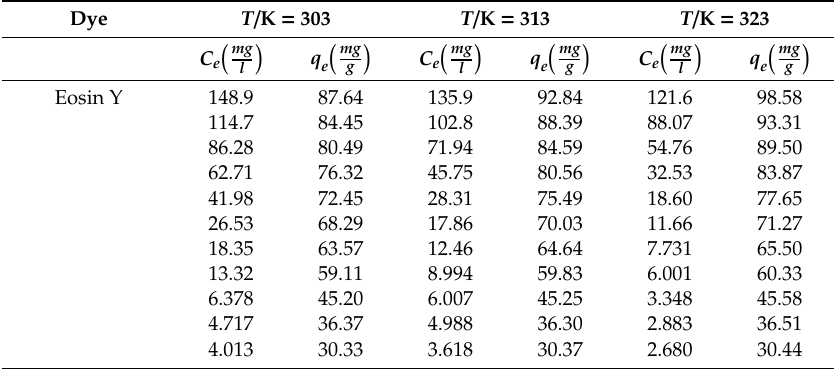
Figure 10. ( a ) Absorbance versus wavelength for indigo carmine ( b ) Absorbance versus concentration for indigo carmine. Table 7. Equilibrium isotherm data for the removal of eosin Y and indigo carmine dye on activated